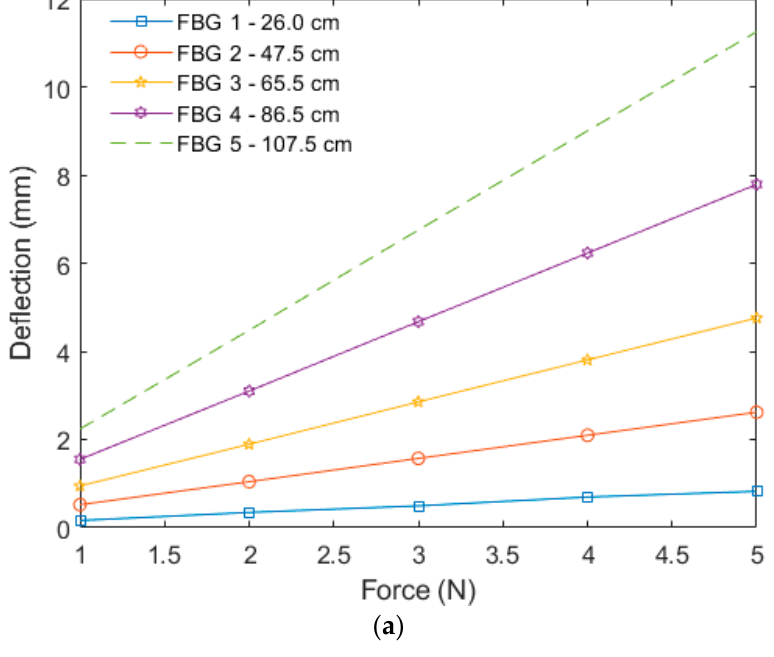
Figure 2. Numerical results of the displacement in the beams with the cantilever configuration for a 5 N load applied on the free end. ( a ) Wooden beam; and ( b ) Nylon 6.0 beam.